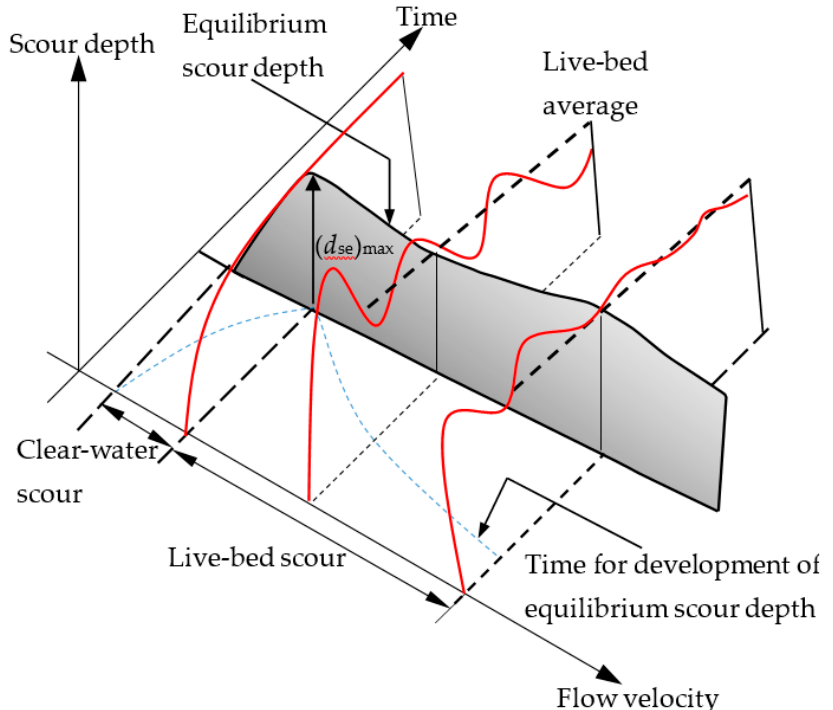
Figure 2. Development of scour depth around a pier, with time and approach velocity. Here, ( d se ) max corresponds to the maximum scour depth at equilibrium condition.